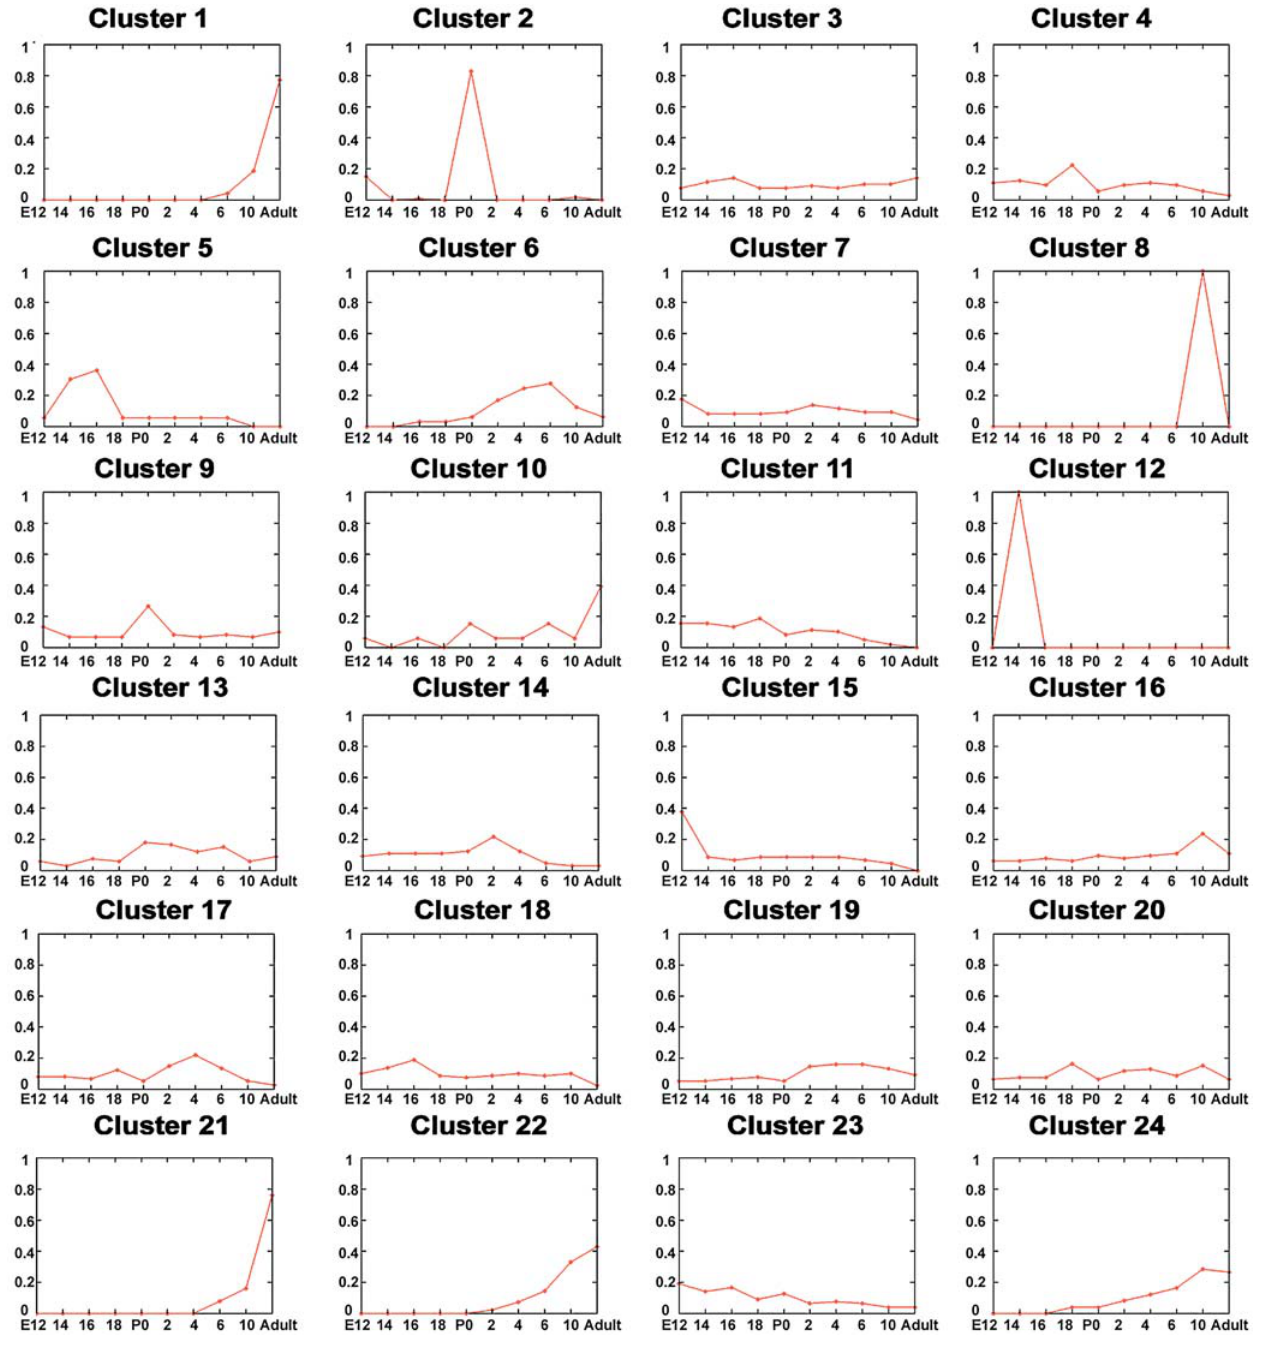
Figure 1. Median Plot of SAGE Tag K- Means Cluster Analysis Using 24 Clusters Tags present at greater than 0.1% in one or more of the ten wild-type total retina libraries are considered. SAGE libraries are plotted on the x- axis, and tag abundance, plotted as a fraction of the total tags for a gene in the library in question, is shown on the y-axis. A full list of tags and their abundance levels used for the analysis is detailed in Table S3. DOI: